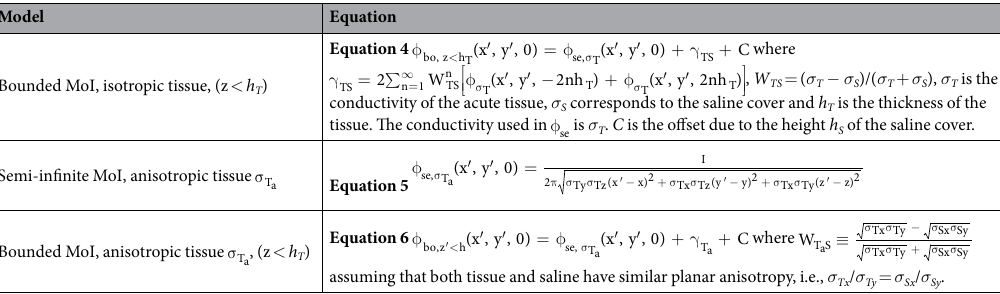
Table 2. Equations to model HD-MEA signals under tissue slices and with saline cover 19,37,59,72,73 .